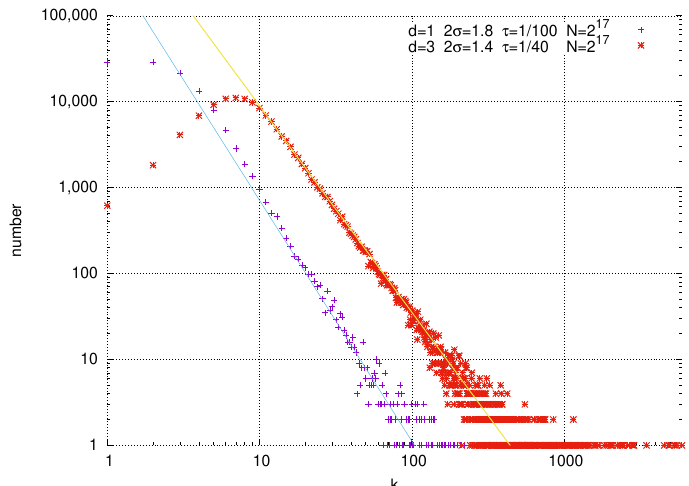
Figure 2. Plot of the degree distribution of the two networks of Figure 1, compared with the corresponding power laws from Equation (35). Here, we are plotting histograms of the node degrees, in the log-log scale, so that the power laws appear as straight